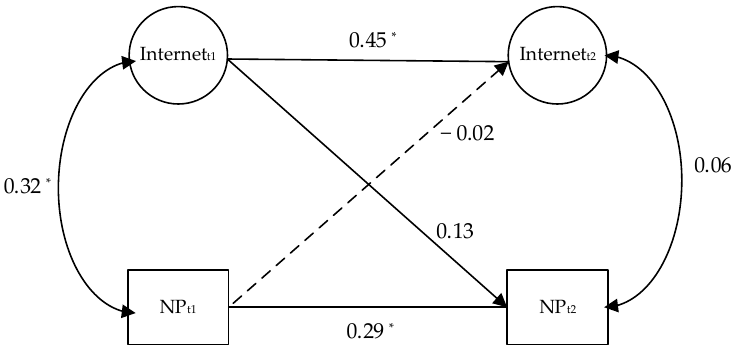
Figure 3. Result of the cross-lagged analyses of the relationship between internet/social media intensity and nonpharmaceutical preventive measures. Note: Internet = internet/social media intensity; NP = nonpharmaceutical preventive measures; t1 = wave 1, t2 = wave 2. * p < 0.05.